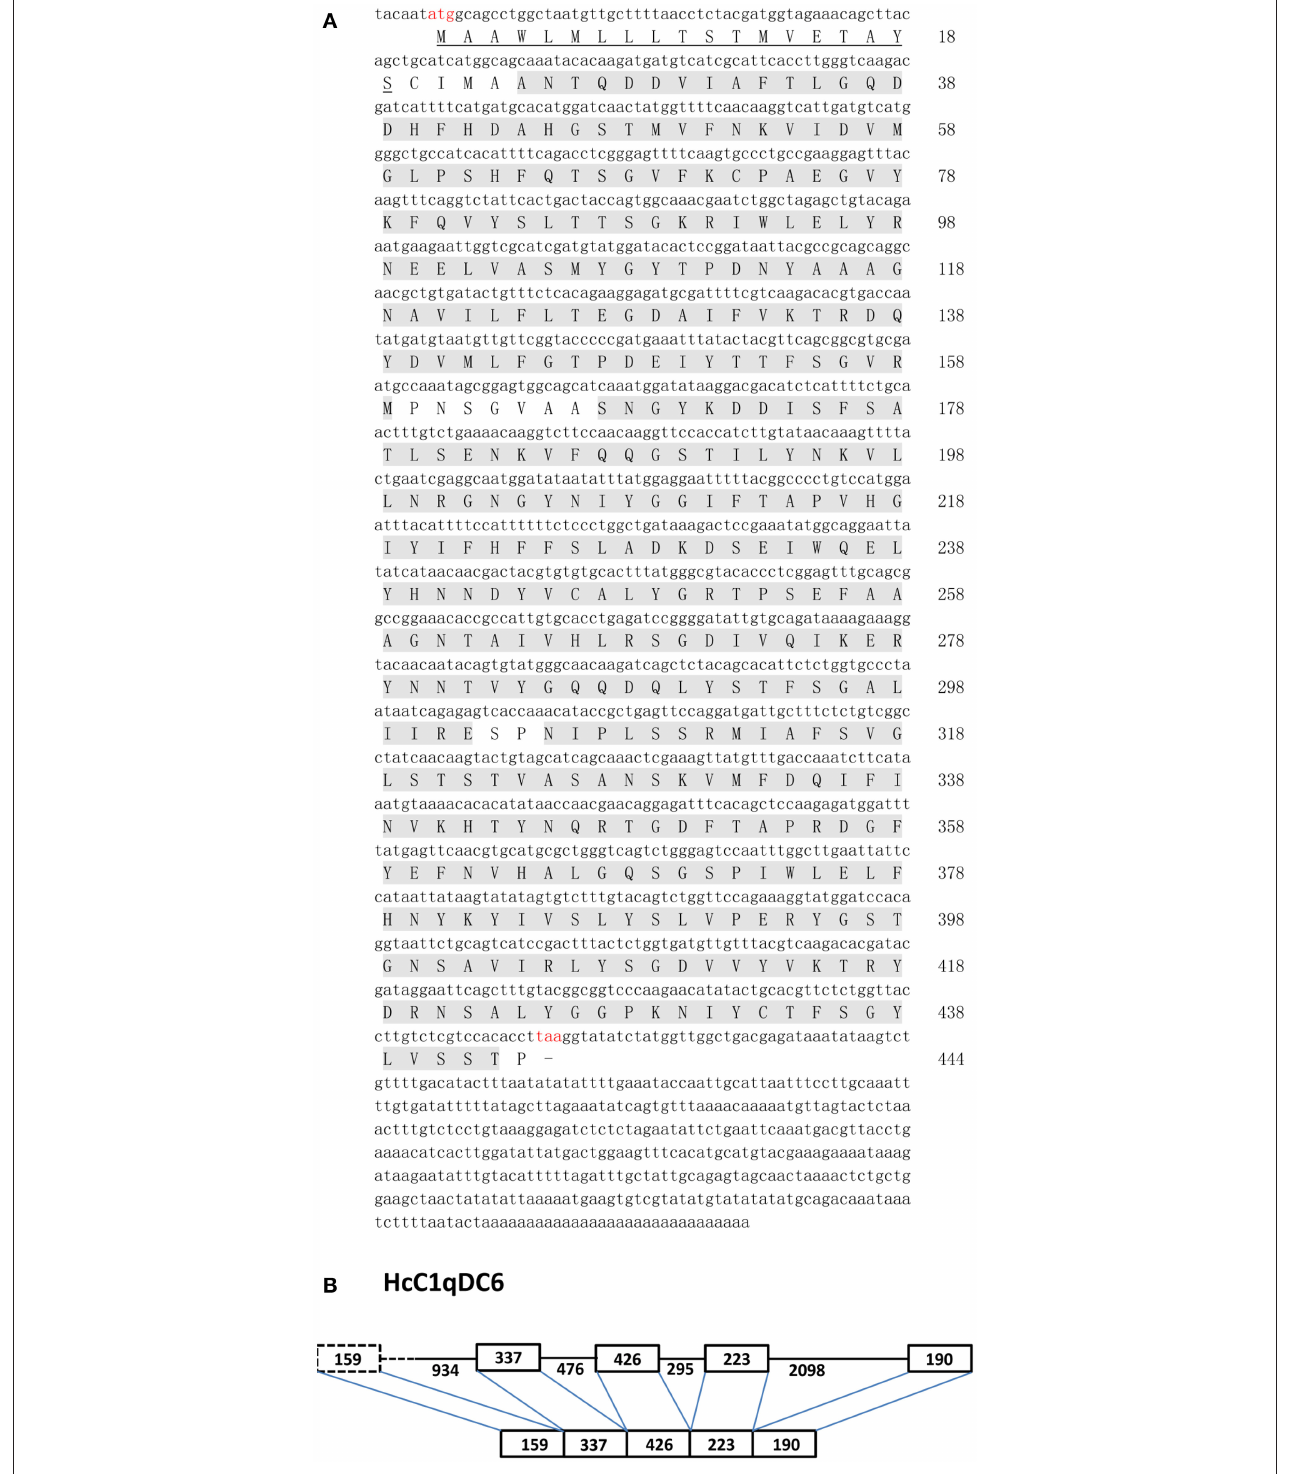
FIGURE 1 | (A) Nucleotide and deduced amino acid sequences of HcC1qDC6 from H. cumingii (above). Signal peptide sequences are underlined, and three C1q domains are shadowed. (B) Genomic structure of HcC1qDC6 (below).